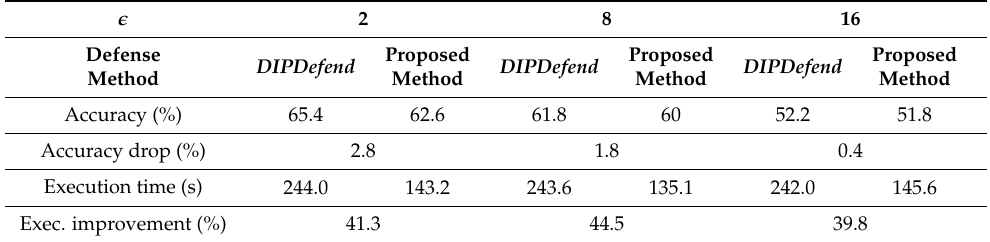
Exec. improvement